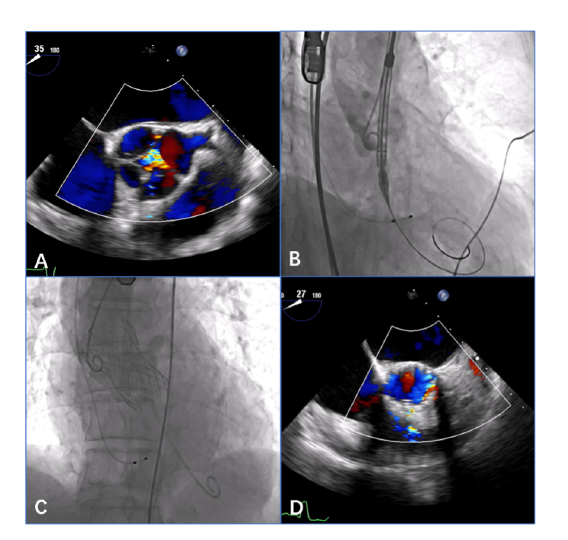
FIGURE3 Procedural details of transcatheter aortic valve replacement (TAVR) with the self-expandable Venus-A prosthesis in a patient with quadricuspid aortic valve with aortic stenosis (AS) and regurgitation. (A) 2-Dimensional transesophageal echocardiography (TEE) with color Doppler showed